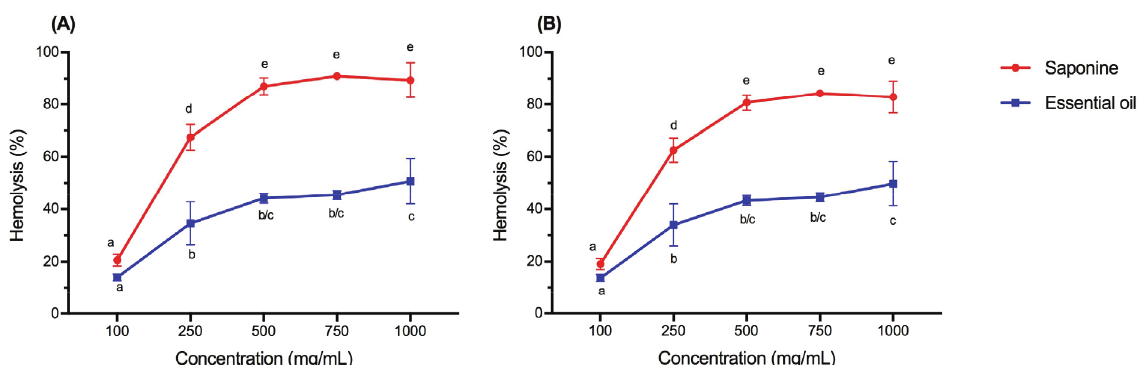
FIGURE 1 - Results obtained in the hemolysis assay when compared to (A) triton 0.1% (w/v) and (B) potable water. Note: Results followed by the same letter, in the same graph, belong to the same statistical